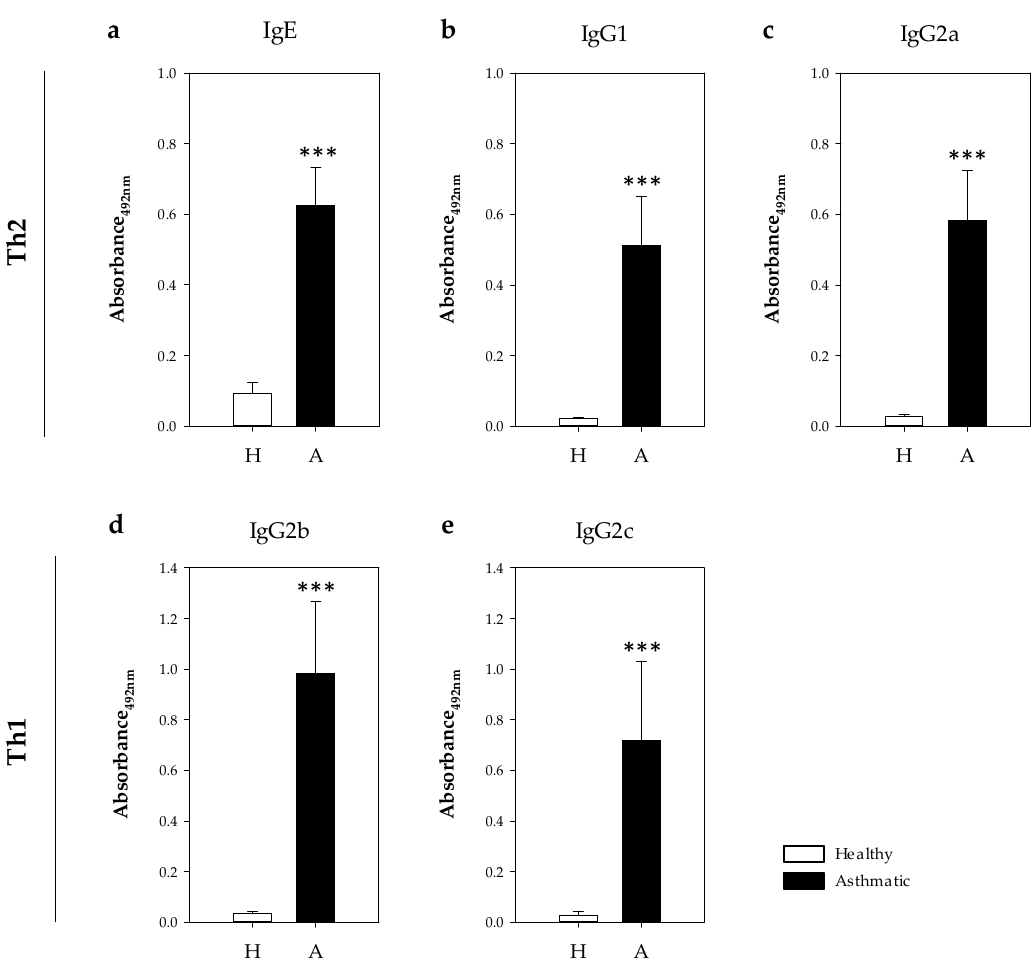
Figure 5. Concentration of serum OVA-specific antibodies 24 h post-challenge. ( a ) IgE, ( b ) IgG1, ( c ) IgG2a, ( d ) IgG2b and ( e ) IgG2c in healthy (H, white bars) and asthmatic (A, black bars) rats. Results are expressed as mean ± standard error (N = 9). Significant differences: *** p < 0.001 vs. healthy animals.